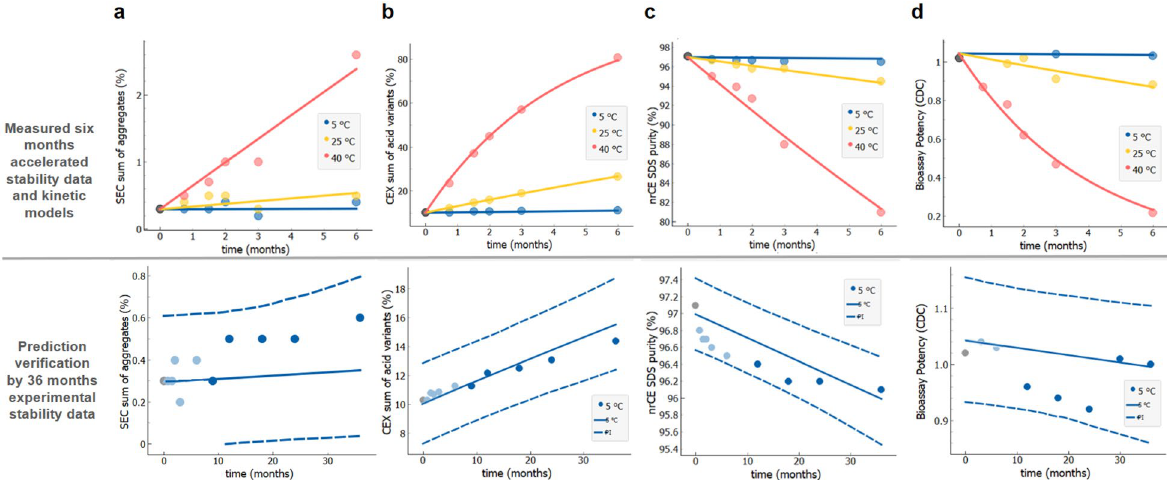
Figure 3. Long-term stability prediction of different stability indicating quality attributes for rituximab. (a) Sum of aggregates by SEC ( R 2 = 0.92), (b) sum of acidic variants by CEX ( R 2 = 1.0), (c) purity by nrCE-SDS ( R 2 = 0.99), (d) complement-dependent cytotoxicity activity (CDC) ( R 2 = 0.99). Accelerated 6 months experimental stability data (upper panels, data points) are used for model parameter calculations (upper panels, full lines). Prediction intervals (dashed blue lines in lower panels) are validated against the available long-term experimental data (bottom panel, dark blue data points). All experimental data are from the single material batch. Measured value at t = 0 is designated by a black solid